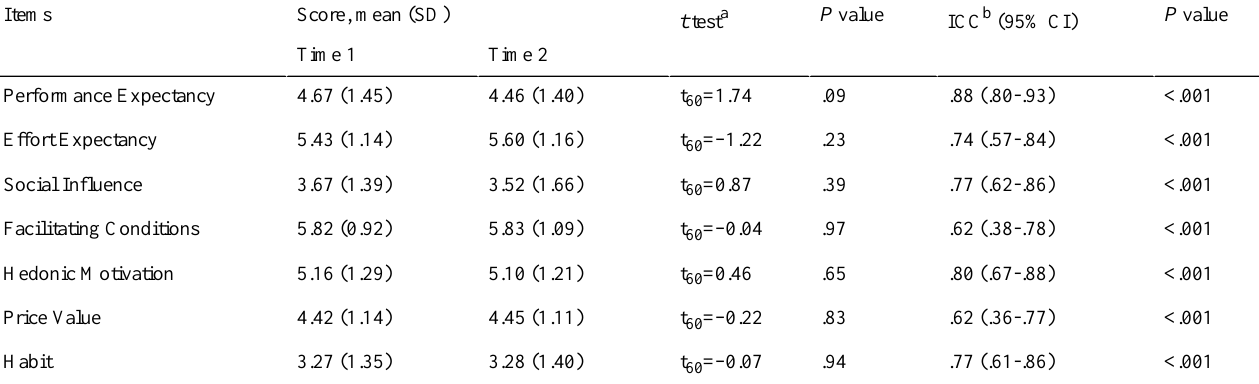
Table 4. Descriptive statistics for the test-retest reliability in sample 5